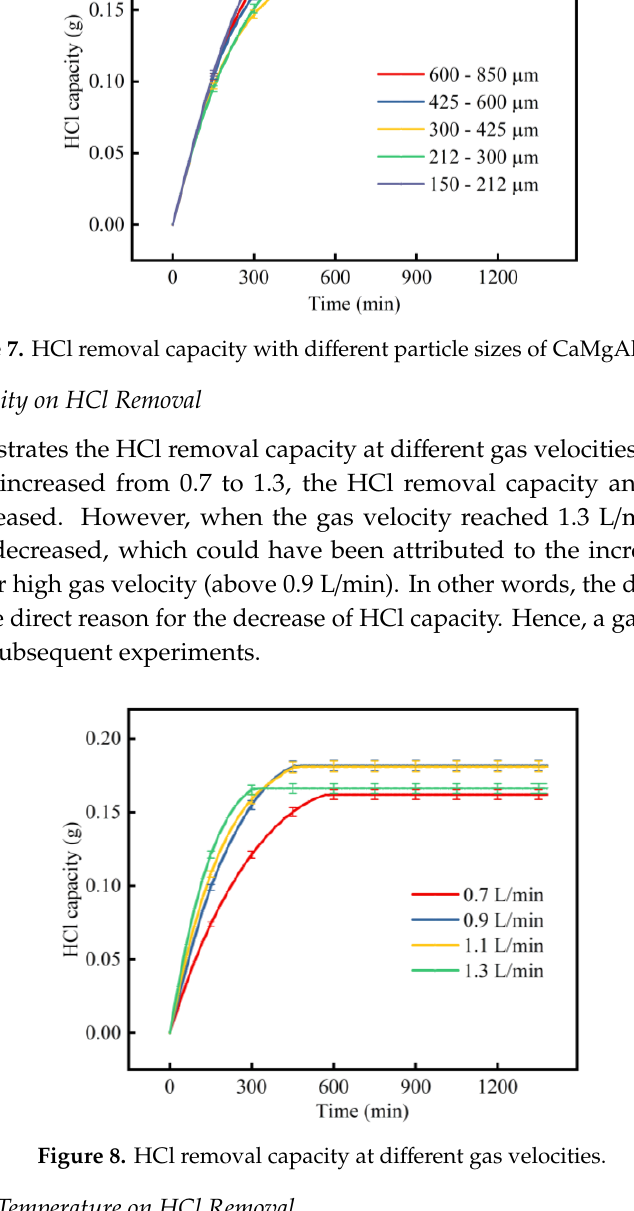
Figure 6. HCl removal capacity with different HCl concentrations under CO 2 concentration of 6%.